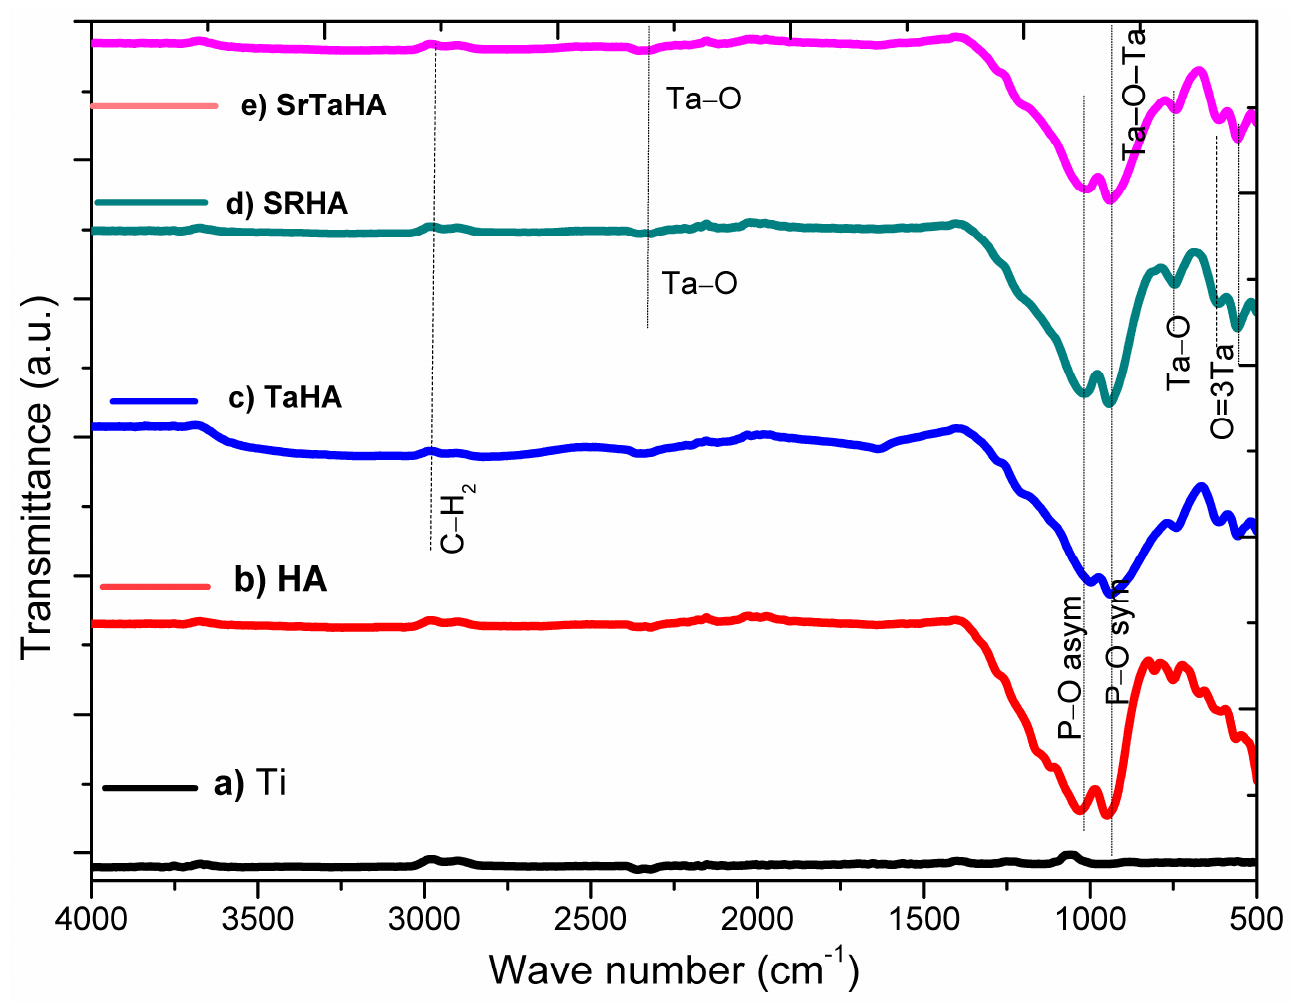
Figure 8. FTIR spectra of ( a ) Surface − Modified Ti, ( b ) HA, ( c ) TaHA, ( d ) SrHA, and ( e ) SrTaHA.